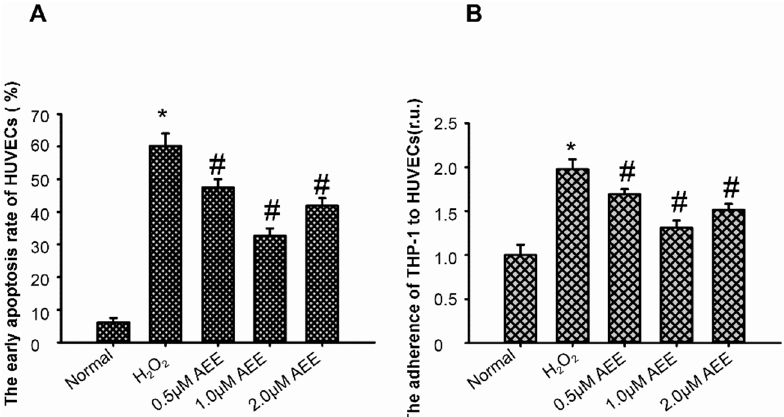
Figure 1. AEE reduced the apoptosis of HUVECs and decreased the H 2 O 2 -induced adherence of THP1 cells to HUVECs. ( A ) AEE reduced the apoptosis of HUVECs induced by H 2 O 2 . Values are presented as the means ± SD where applicable ( n = 6). * p < 0.05 compared with the normal group; # p < 0.05 compared with the H 2 O 2 group. ( B ) AEE decreased the H 2 O 2 -induced adherence of THP1 cells to HUVECs. Values are presented as the means ± SD where applicable ( n = 6). All data were normalized to the corresponding control and reported in relative units (r.u.).